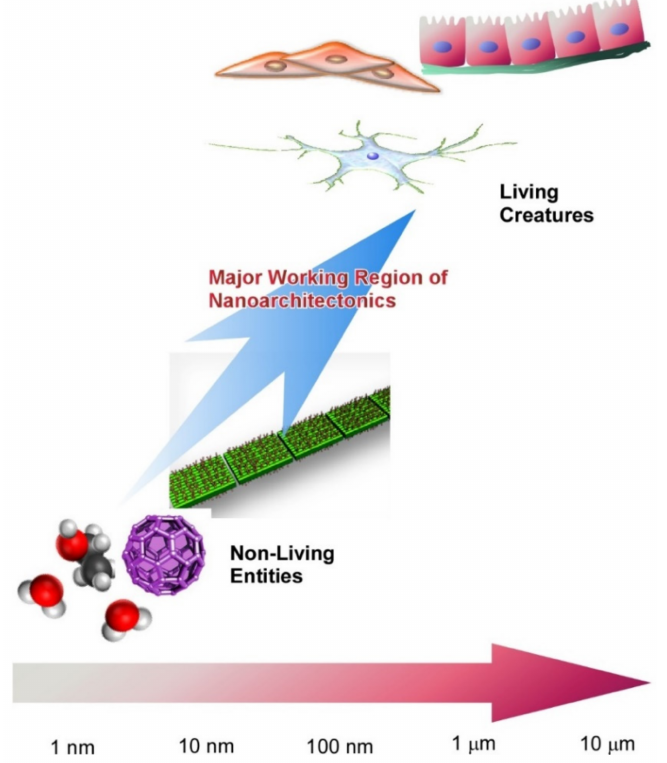
Figure 2. A goal of nanoarchitectonics: creation of highly functional systems similar to those found in biological